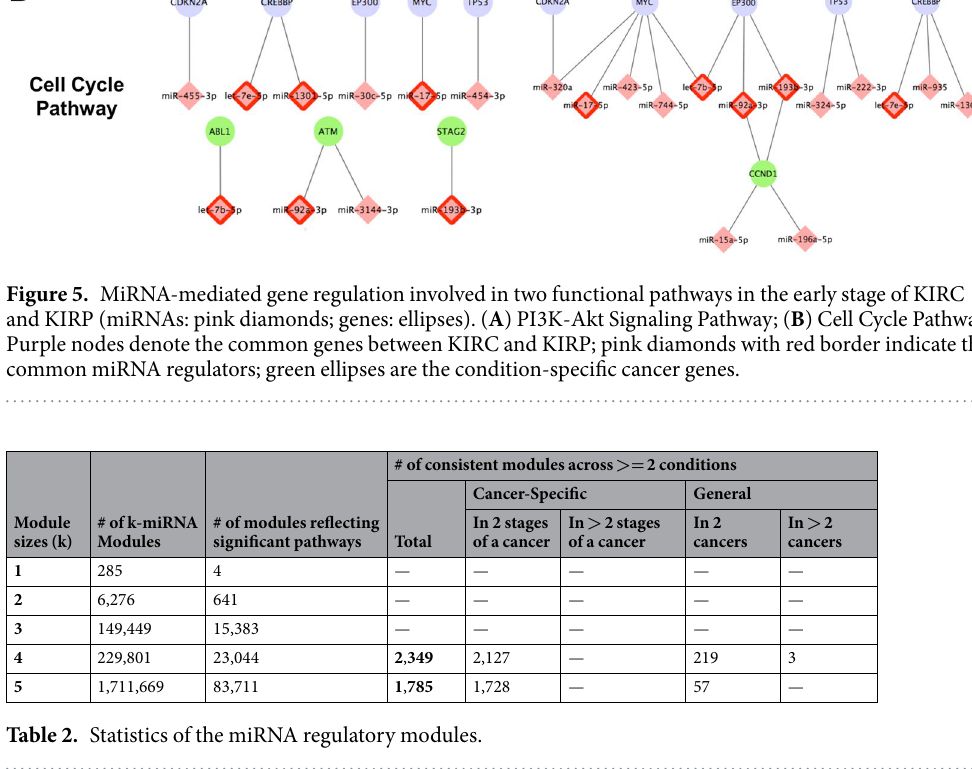
Table 2. Statistics of the miRNA regulatory